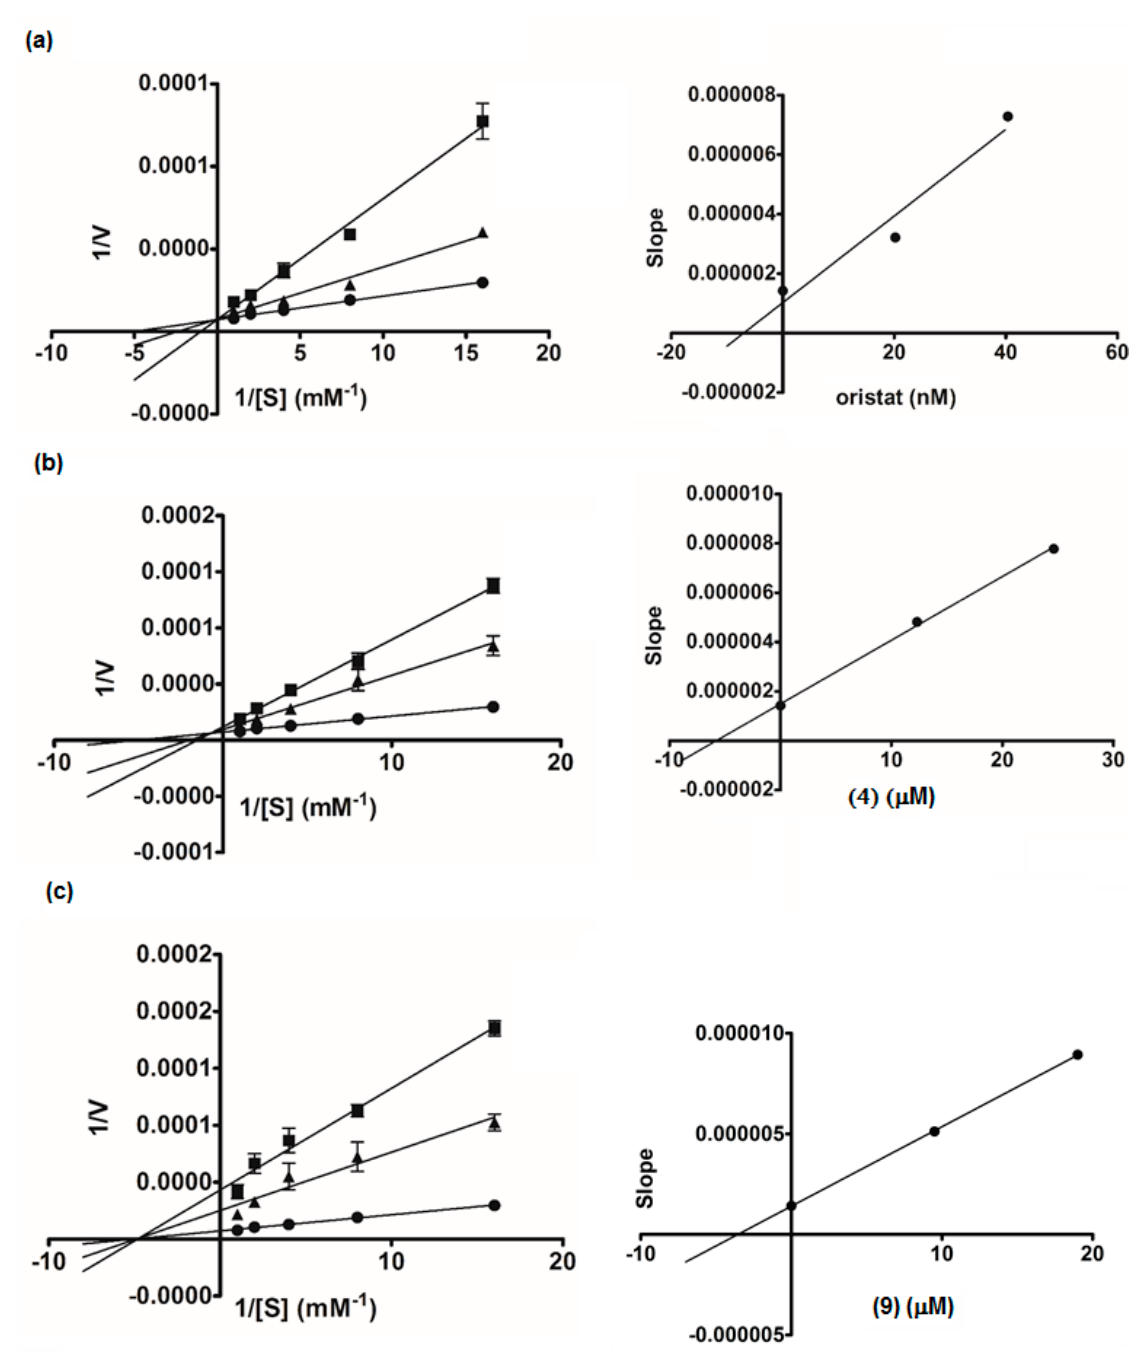
Figure 5. Lineweaver-Burk plots of orlistat ( a ): ● control, ■ orlistat 20 ng/mL, ▲ orlistat 10 ng/mL; isopanduratin A ( 4 ) ( b ): ● control, ■ ( 4 ) 10 µg/mL, ▲ ( 4 ) 5 µg/mL; Compound 9 ( c ): ● control, ■ ( 9 ) 20 µg/mL, ▲ ( 9 ) 10 µg/mL. The secondary plot of each compound is on the right.